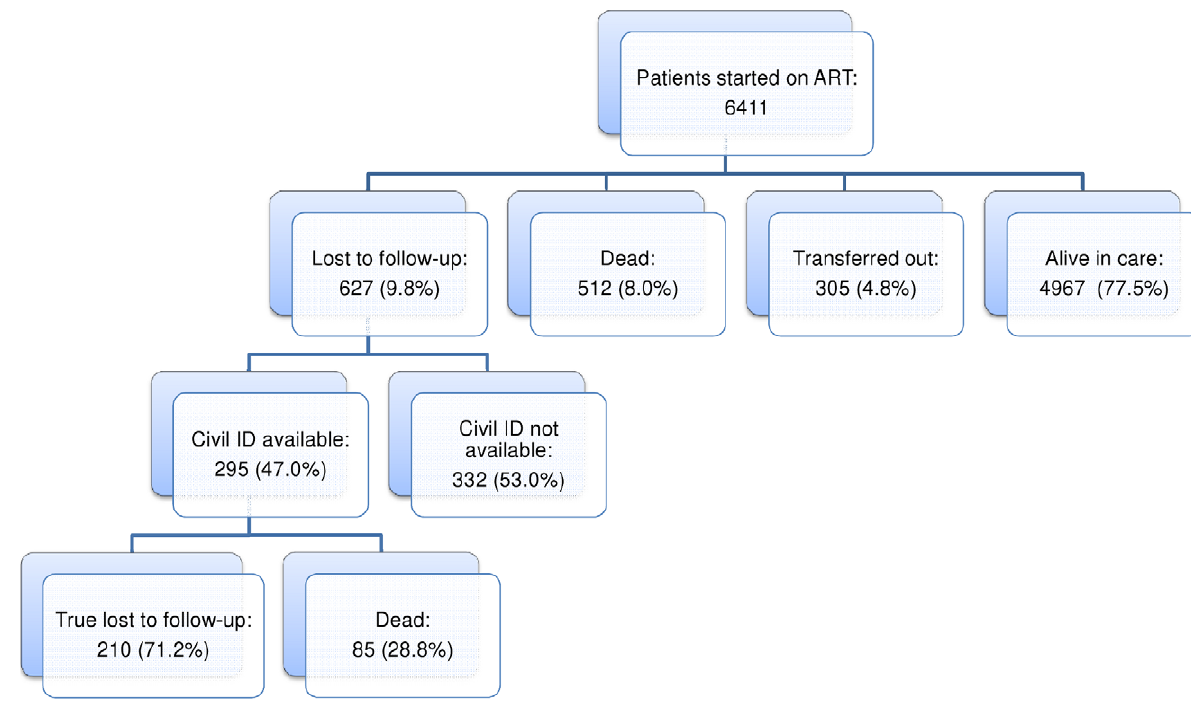
Figure 1. Summary diagram of patient outcomes.